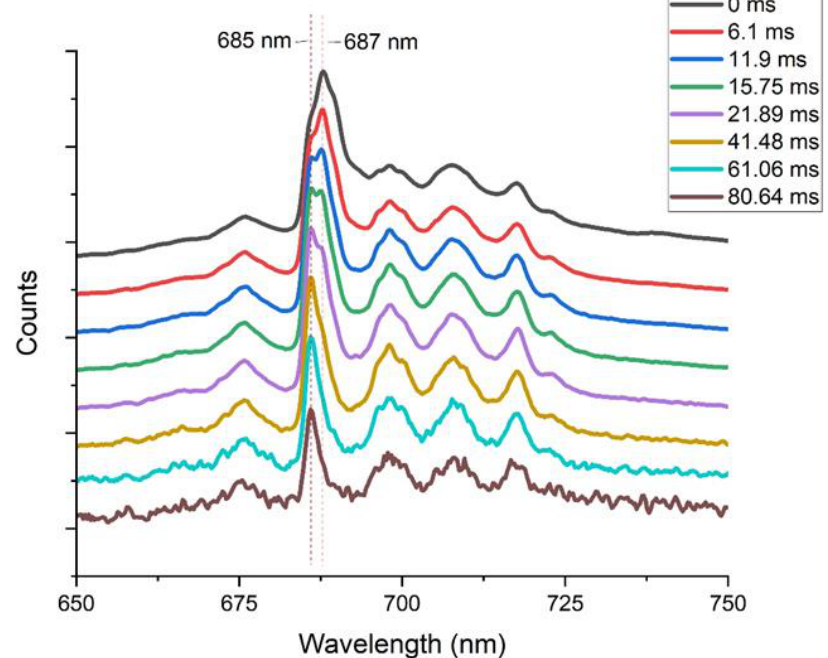
Figure 5. Time-resolved fluorescence decay spectra of the flux lab grown and heated spinel.